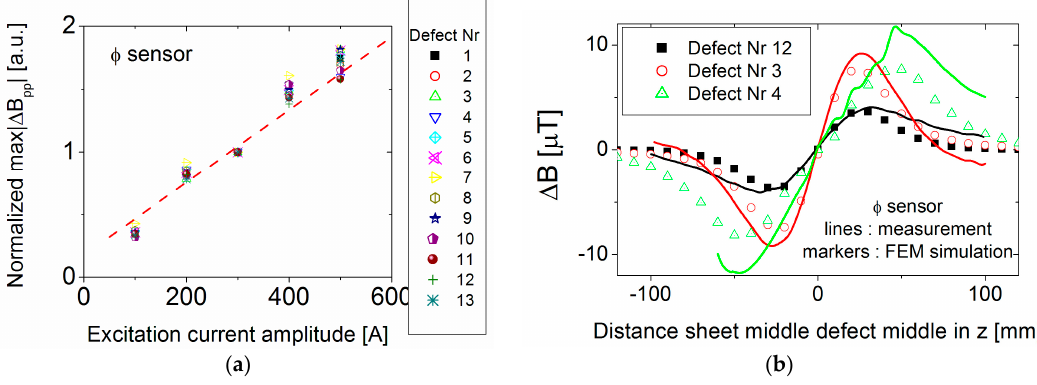
Figure 12. ( a ) Maximum peak-to-peak change in magnetic field amplitude for the Φ -sensor normalized to 300 A; ( b ) comparison of measured and FEM simulation results of change in magnetic field amplitude for the Φ -sensor located at the defect edge and moving over the defect in the z direction.